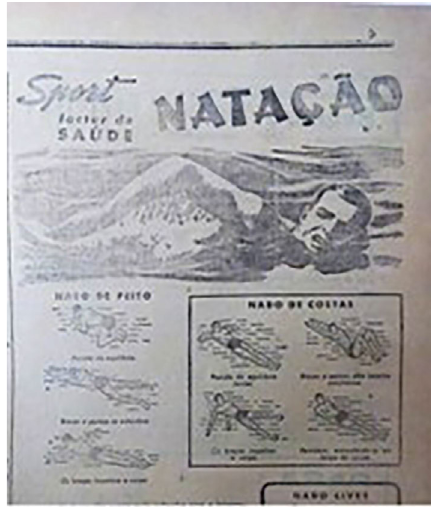
Figure 3 - Gillette advertisement featuring swimming. Source: Gazeta do Norte (Minas Gerais). Saturday, 20 December 1941, p.